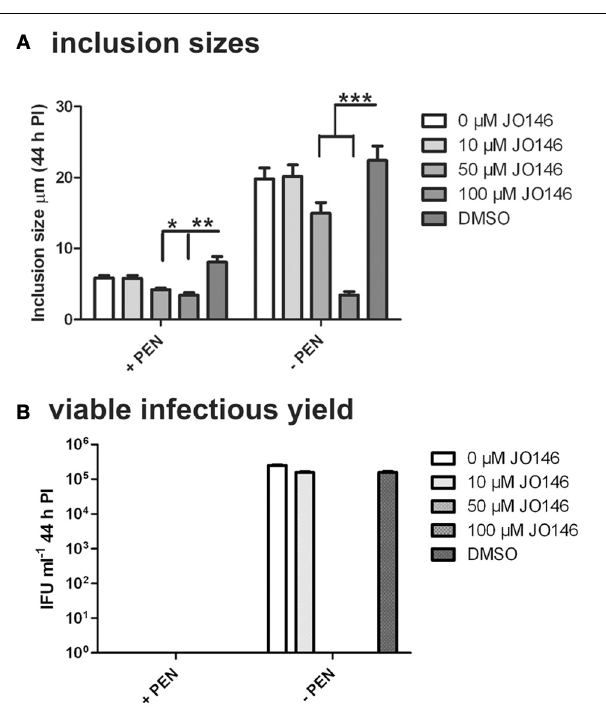
FIGURE 3 | Inclusion sizes and viable infectious yield during penicillin persistence at 44h PI with and without JO146 treatment. The figure shows morphological analysis of cultures during penicillin persistence and controls by measuring inclusion sizes. The viable infectious yield (44h PI) in the presence or absence of 100 U ml − 1 penicillin (4h PI) is shown on the graph. (A) Inclusion sizes are shown from each condition inclusion sizes were measured from independent coverslips, n = 20. (B) Viable infectious yield with and without penicillin are shown graphically ( n = 27). Statistics were conducted using Two-Way ANOVA relative to DMSO controls, p > 0 . 5 ∗ , p > 0 . 01 ∗∗ , p > 0 . 001 ∗∗ , P > 0 . 0001 ∗∗∗ .